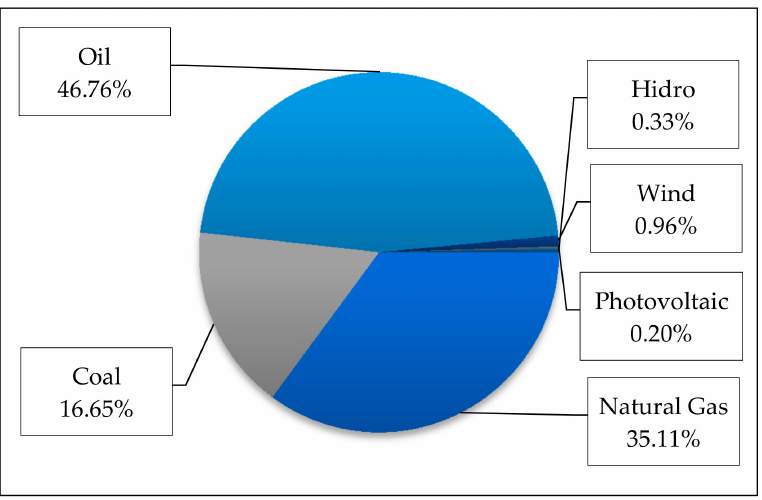
Figure 3. Distribution of generating sources for FY